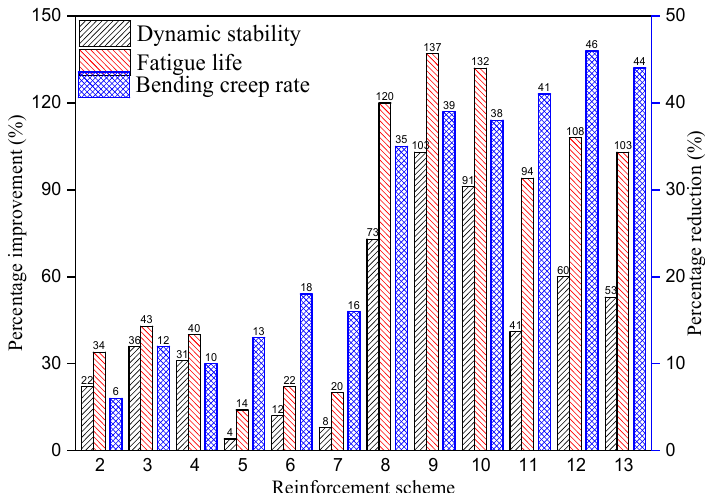
Figure 9. The variation of dynamic stability, fatigue life and bending creep rate under different re- inforcement schemes. reinforcement